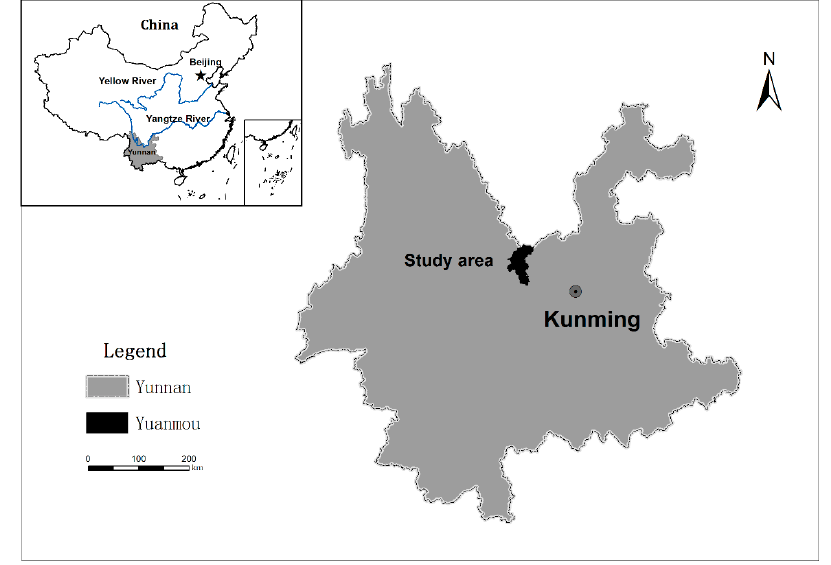
Figure 1. The geographical location of the study area.